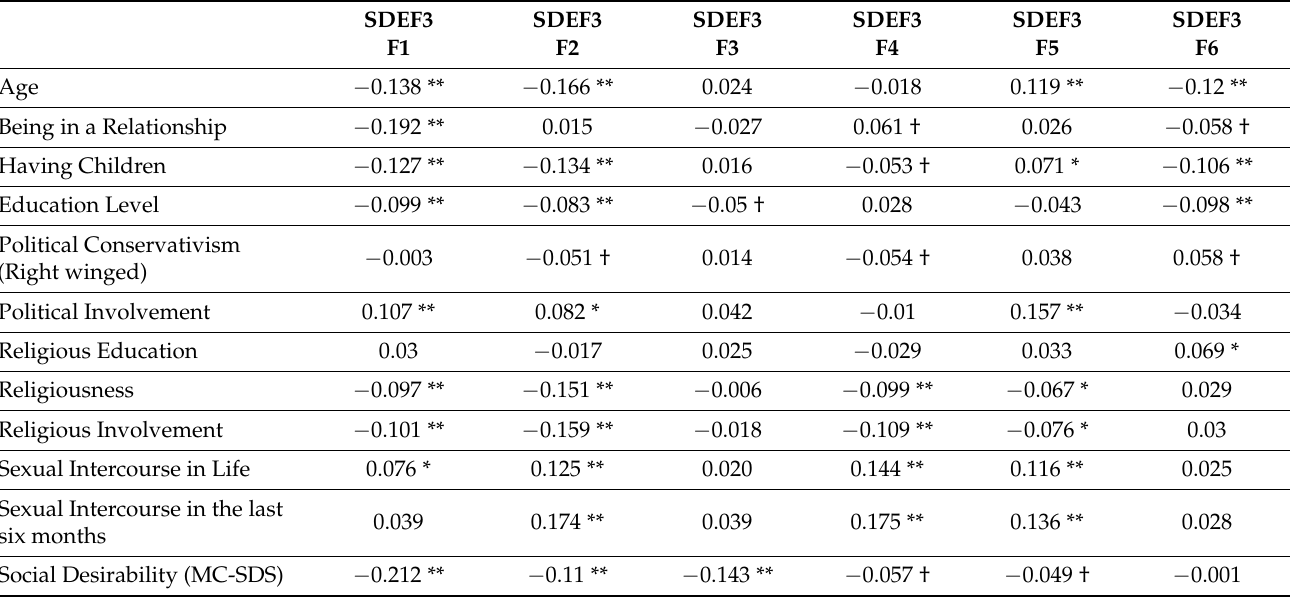
Table 4. Person’s correlation matrix between SDEF3 six-factor solution, sociodemographic variables and social desirability (MC-SDS) ( n = 1773).